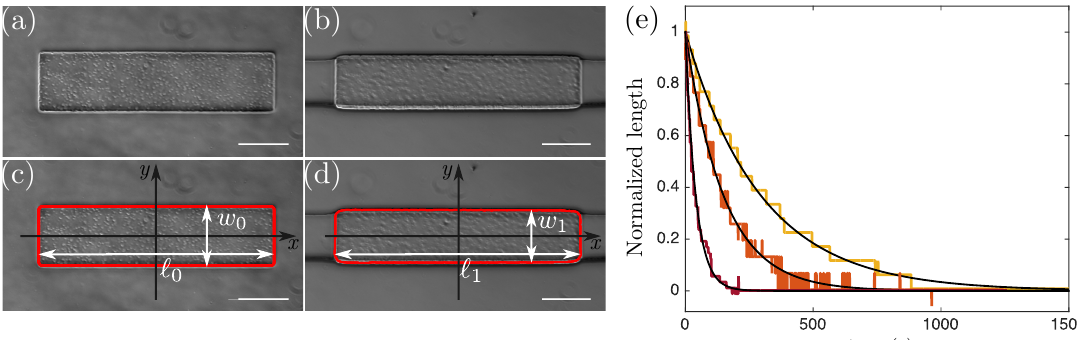
Figure 2. Pictures of the slab in the wide ( a , c ) and in the narrow ( b , d ) part of the channel. ( a , b ) correspond to raw images of the undeformed and deformed particle, respectively.In (b) the dark region around the particle corresponds to the channel walls. ( c , d ) show the determination of the shape using MatLab. Scale bars are 200 µ m. ( e ) Temporal evolution of the particle length after the flow was stopped ( t = 0). Length at time t was normalized by subtracting the equilibrium length and dividing by the difference between the initial length and the final length. Three different hydrogels are represented: from right to left, PP 20 (yellow), PP 30 (orange), and PP 40 (red). Exponential fits (black lines) are represented as a guide for the